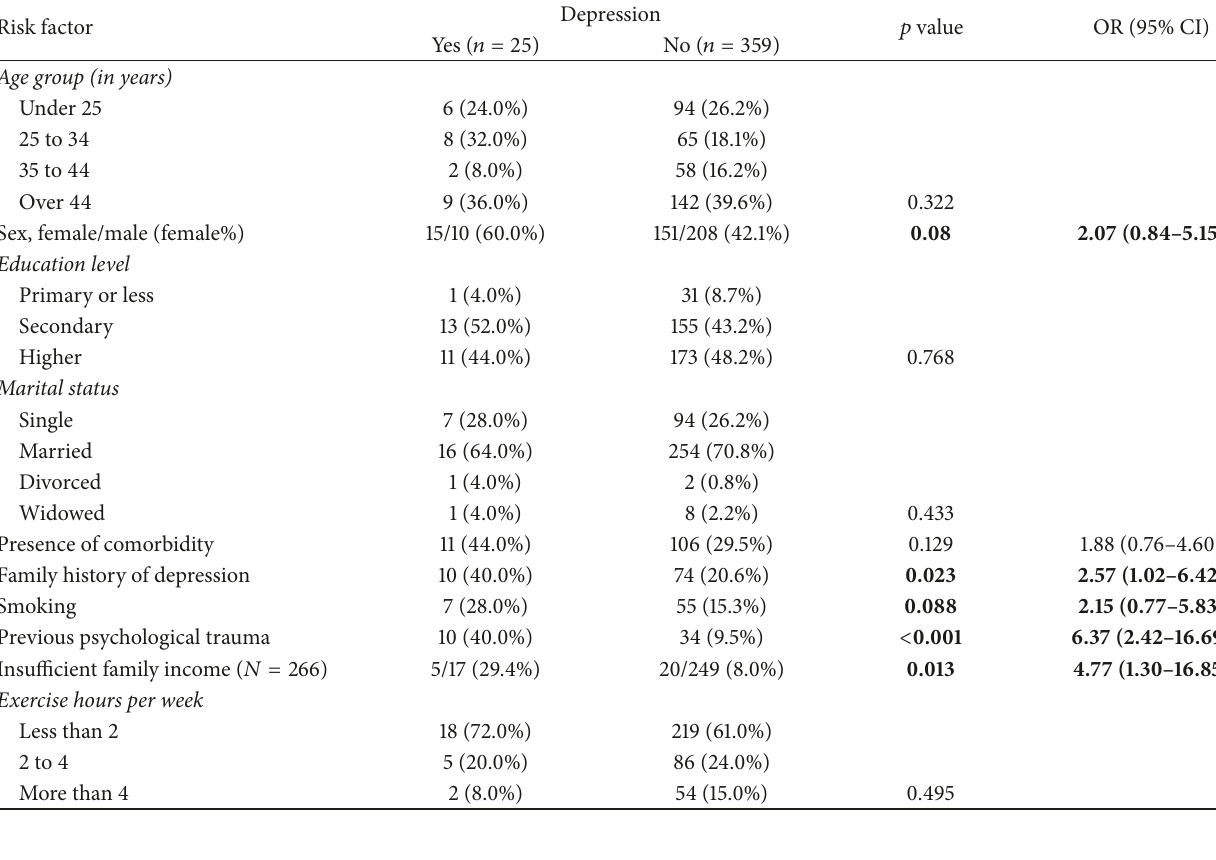
Table 2: Risk factors against DSM-IV depression status.